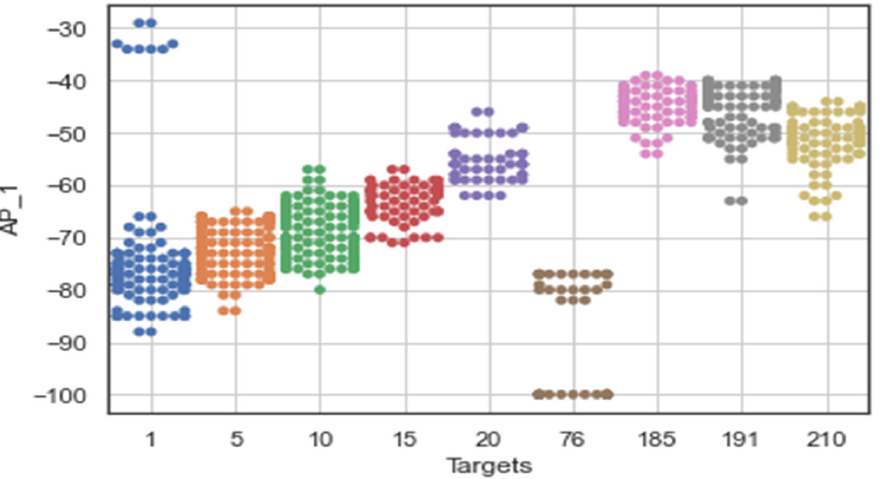
Figure 6. Distributions of RSS for Wi-Fi AP1 with some portion of the targets for dataset A.